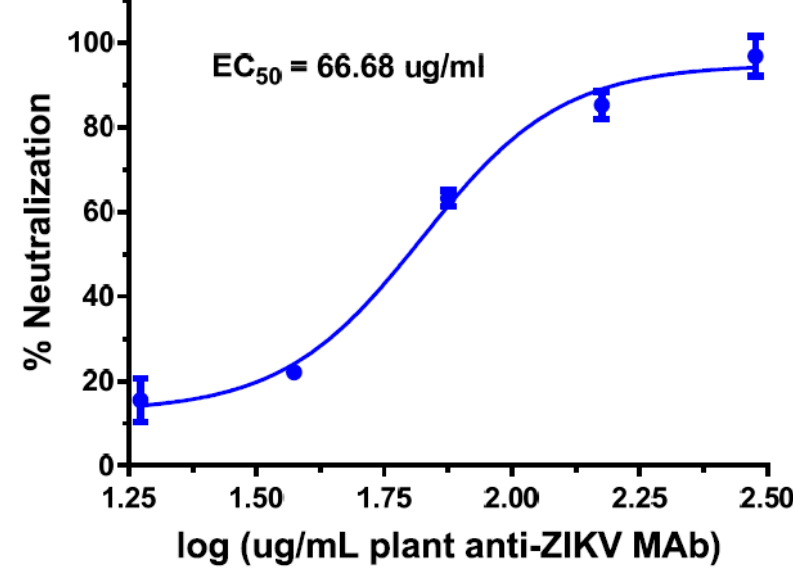
Figure 7. Neutralization of ZIKV by a plant-produced mAb. ZIKV (Puerto Rico strain) was incubated with serial dilutions of a ZIKV E protein-specific mAb and used to infect Vero cells. Cells were overlaid with fresh culture medium containing 0.8% agarose, fixed in paraformaldehyde, and then stained with crystal violet. EC50 value is listed in the graph.